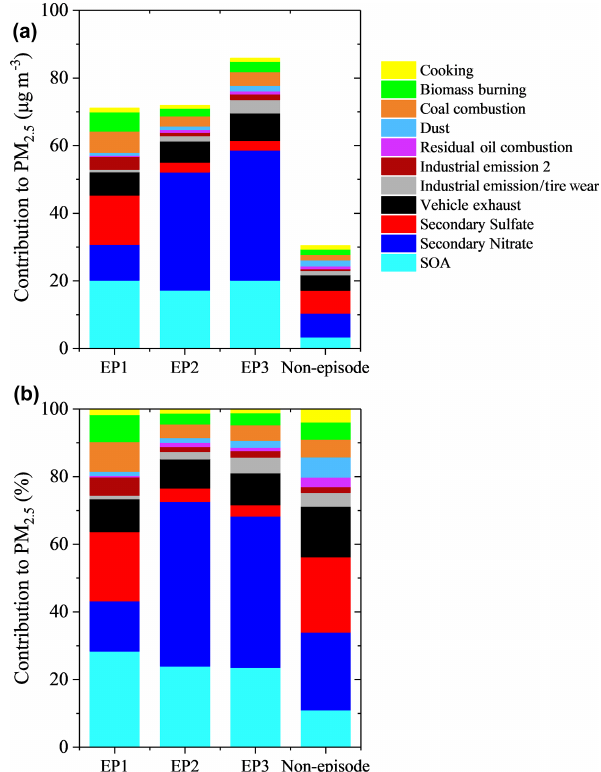
Figure 8. Source contributions to PM 2 . 5 from individual MM-PMF source factors during the three episodes encountered in the measure- ment period: (a) mass contributions (µgm − 3 ) and (b) percentage contributions (%). The source contributions for nonepisodic hours are also included for